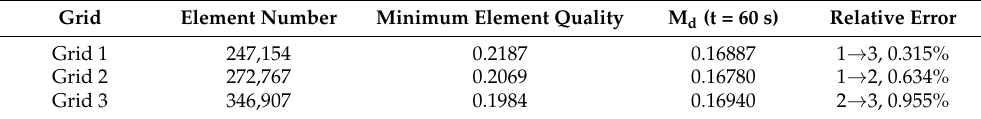
Table 3. Grid-independent verification( v = 1.5 m/s, T = 60 ◦ C).